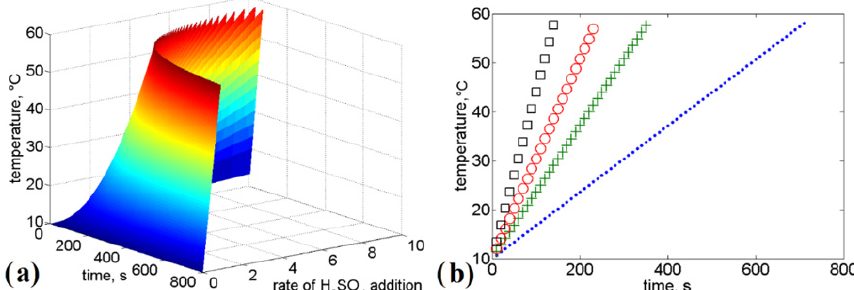
Figure 3. ( a ) Comparison of the reaction blend temperature considering the influence of input flow addition (O) and constant volume ( ♦ ), ( b ) error variation presented as percentage, 0 ≤ τ ≤ 60 min.